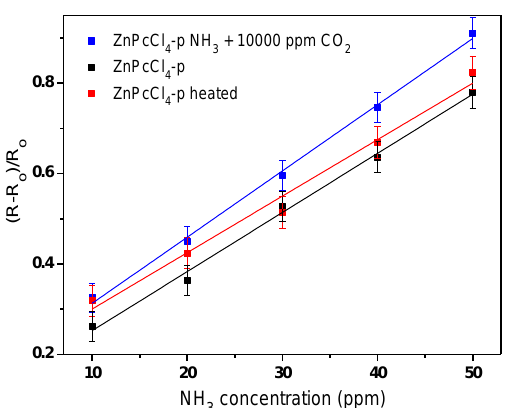
Figure 12. Sensor response of a ZnPcCl 4 -p film to ammonia (10–50 ppm) and to ammonia in the presence of 10,000 ppm CO 2 , measured at RH 10% and 25 °C and after heating to 100 °C.